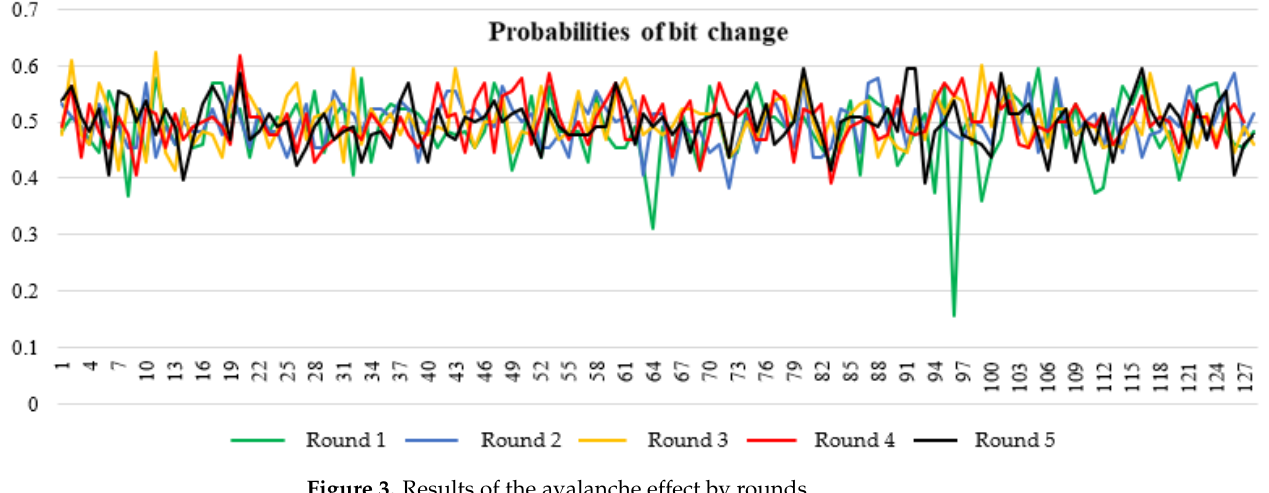
Figure 3. Results of the avalanche effect by rounds. Table 3. Results of the conducted statistical tests by